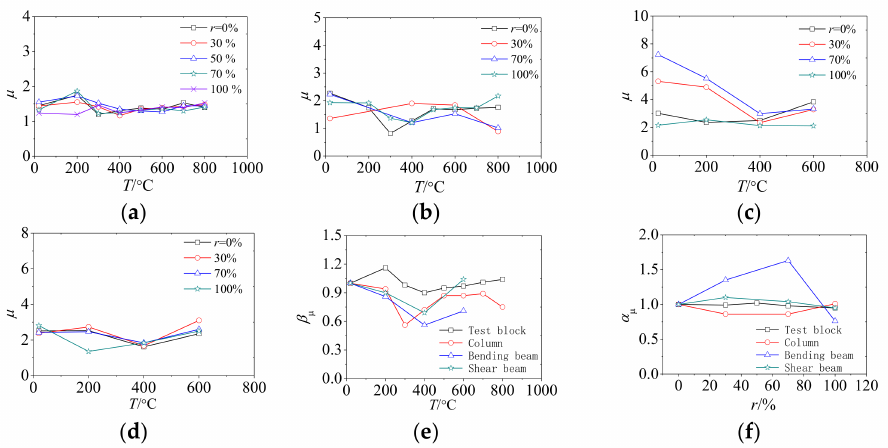
Figure 17. Ductility. ( a ) rectangular prisms specimens; ( b ) columns; ( c ) bending beams; ( d ) shear beams; ( e ) The influence of temperature; ( f ) The influence of replacement